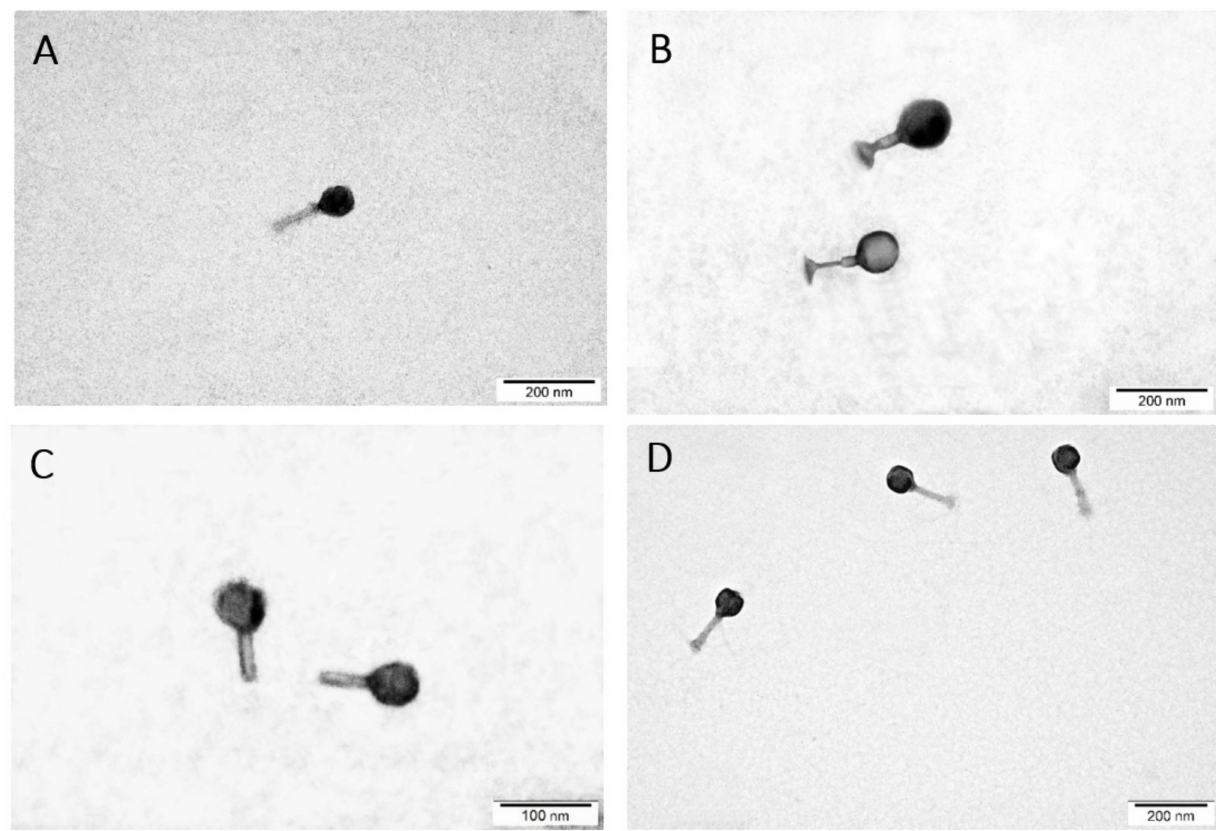
Figure 3. Morphology of the bacteriophages in transmission electron microscopy (TEM): ( A ) Citrobacter phage KKP 3664, ( B ) Enterobacter phage KKP 3262, ( C ) Enterobacter phage KKP 3263, ( D ) Serratia phage KKP 3264. Images of preparations were stained with the following solutions: ( A , C )—2% phosphotungstic acid, ( B )—2% uranyl acetate, and ( D )—0.5% iron (II)